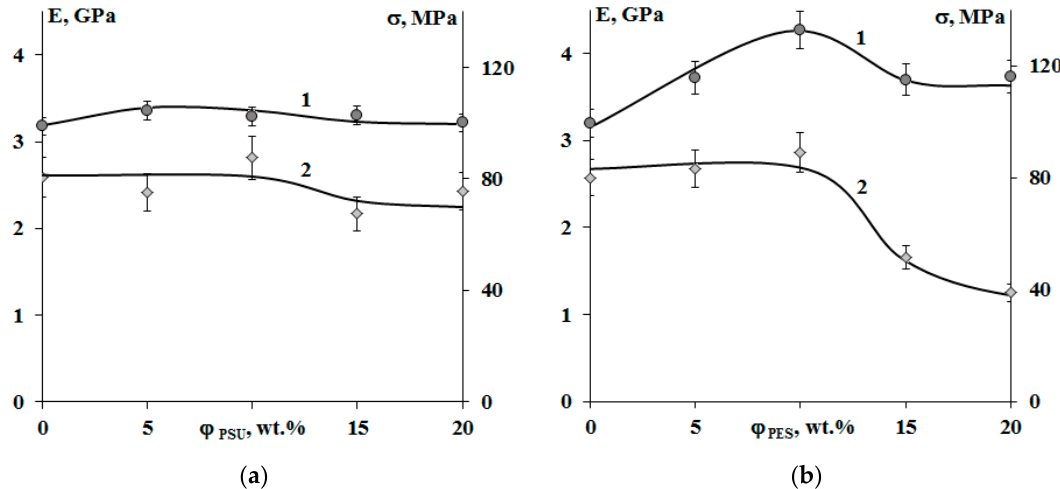
Figure 12. Concentration dependences of the elastic modulus (1) and tensile strength (2) of cured epoxy–TP compositions modified with PSU ( a ) and PES ( b ). Temperature − 20 ◦ C.